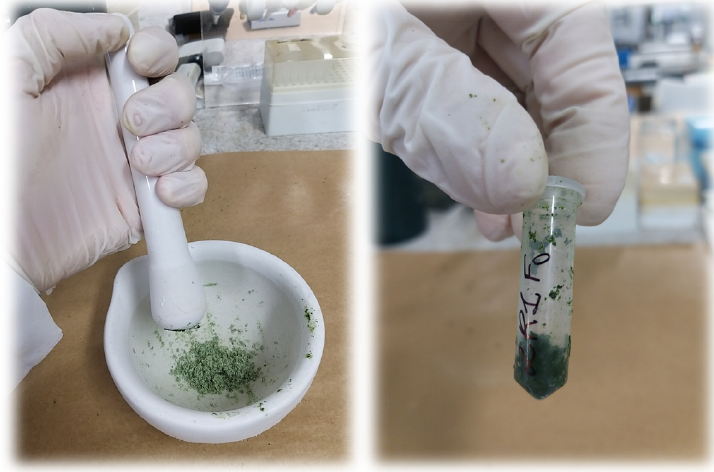
Figure 2. Detail of sample preparation for extracting